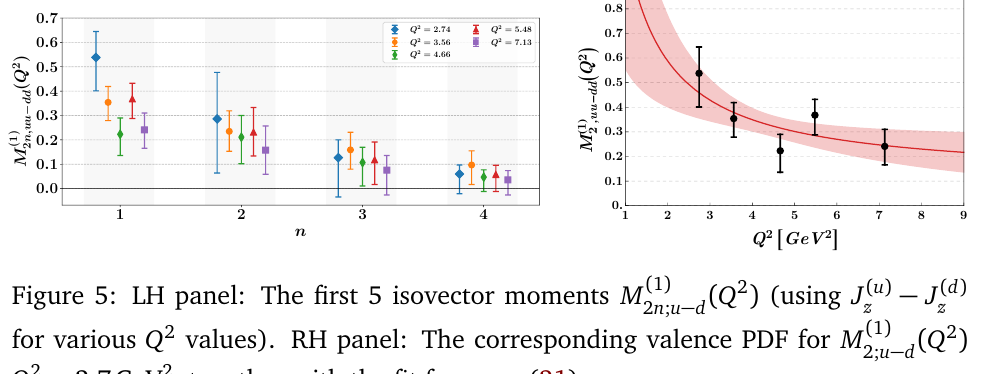
( 1 ) ( Q 2 ) (using J ( u ) − J ( d ) z z 2 n ; u − d ( 1 ) ( Q 2 ) 2; u − d